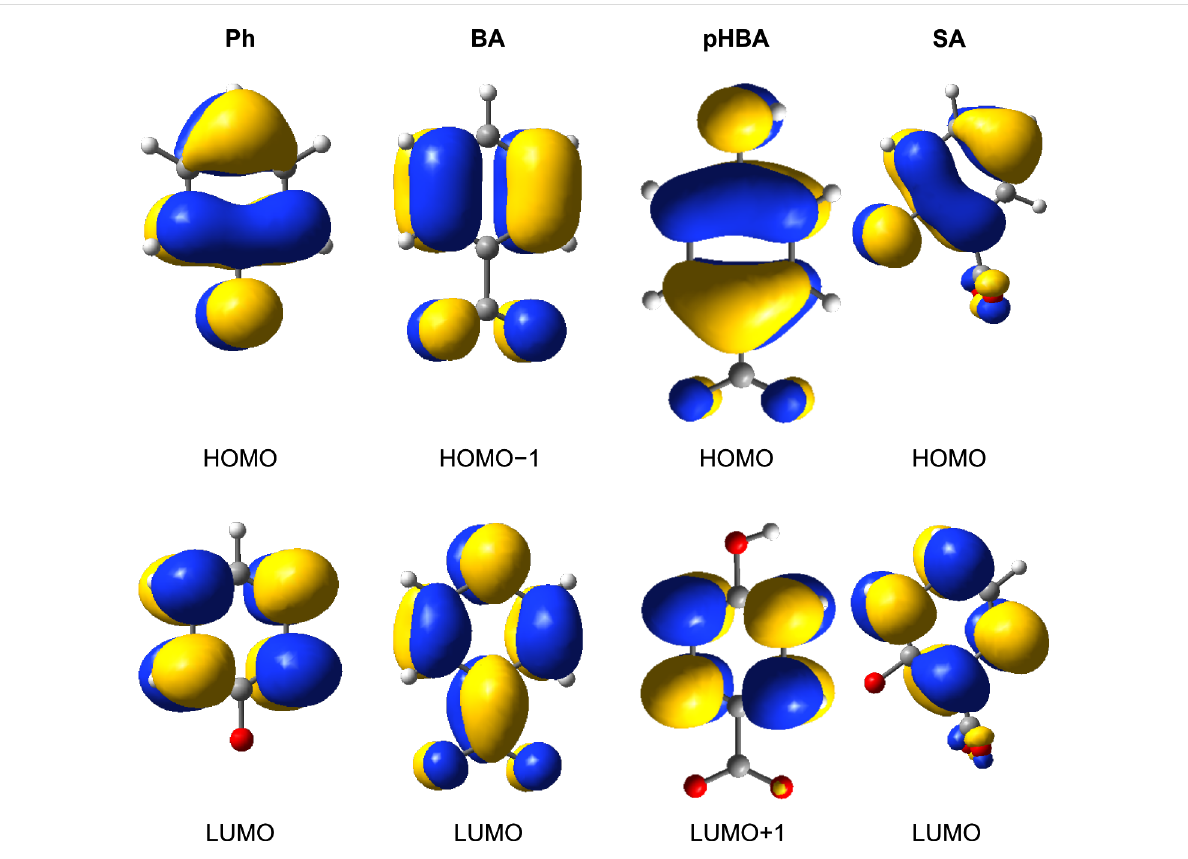
Figure 4: Isodensity surfaces (0.03 e /bohr 3 ) of the key molecular orbitals of the deprotonated pollutants, calculated at DFT/B3LYP/ TZVP level in water. In the case of pHBA and SA the deprotonation is on the carboxy